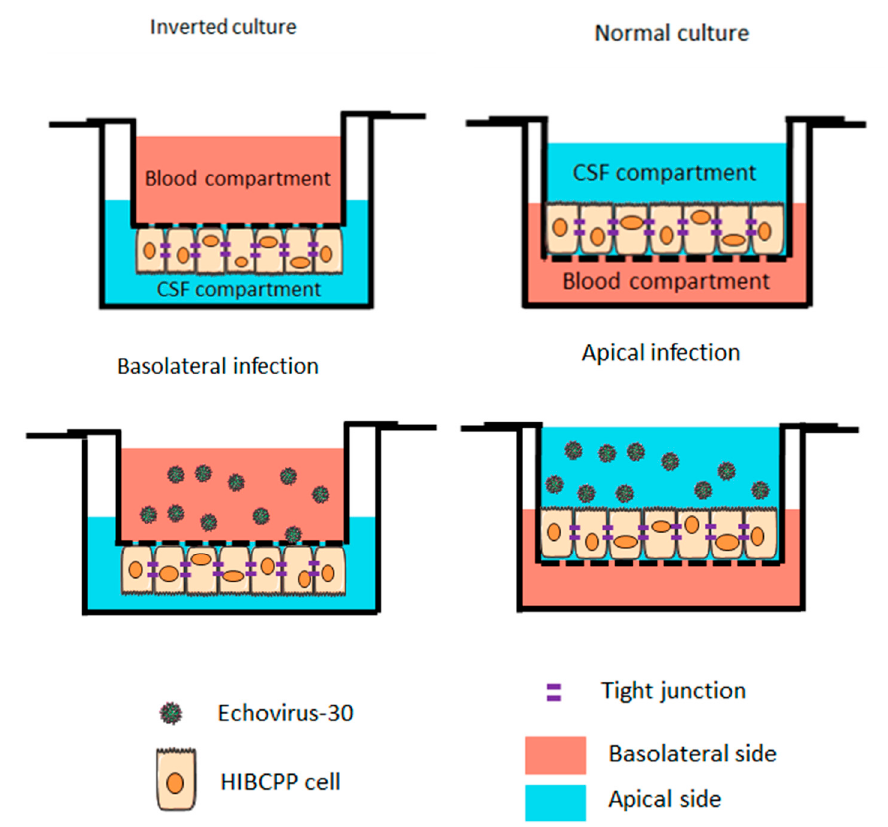
Figure 1. Schematic representation of infections with Echovirus 30 on the basolateral and apical side of the human choroid plexus papilloma (HIBCPP) cells. Schematic representation of HIBCPP cells in inverted culture ( left ) versus a normal culture ( right ). The HIBCPP cells are infected with E-30 on their apical side in normal culture, whereas they are infected on their basolateral side in inverted cultures.